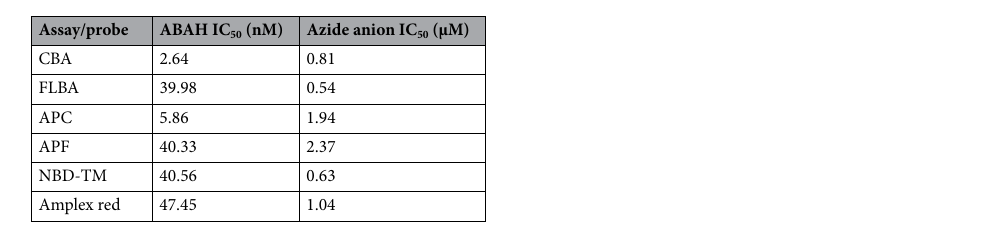
Table 1. IC50 values for ABAH and azide anion determined by means of the CBA, FLBA, APC, APF, and NBD-TM probes.